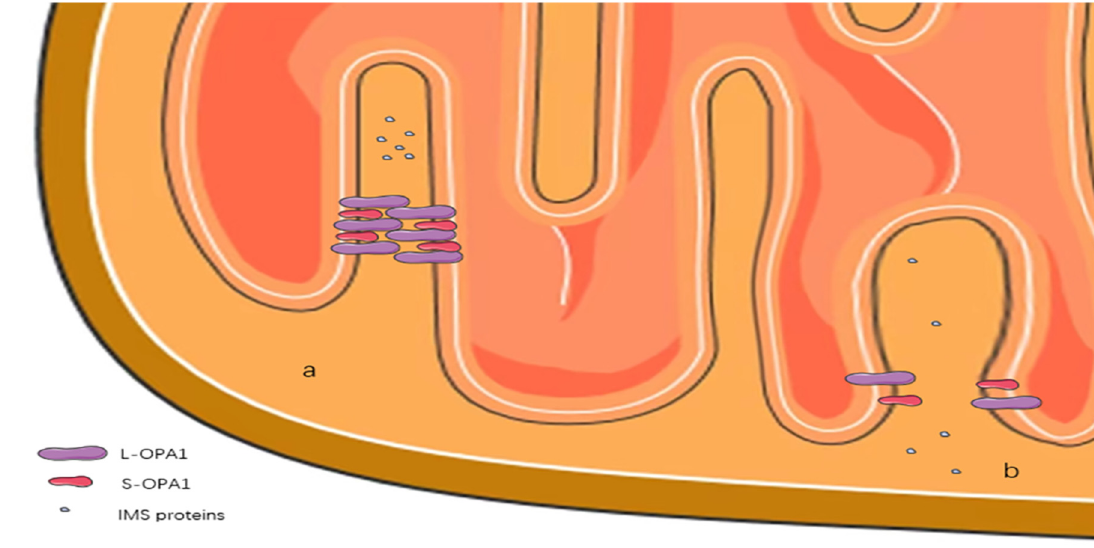
Figure 3. Cristae remodeling. (a): Under normal conditions, L-OPA1 and S-OPA1 are able to form oligomers to maintain the structure and function of the cristae. (b): The cristae remodel, the opening of the cristae becomes larger, and the contents of the cristae are